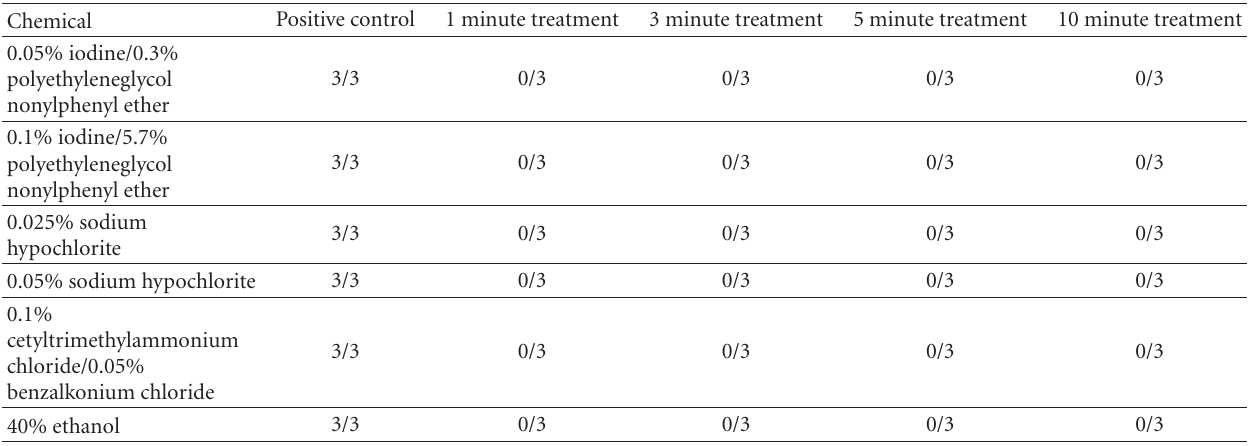
Table 1: The e ff ectiveness of disinfectants on vaccinia virus. Table 1 describes the number of plates (based on triplicate assays) with any wells showing cytopathic e ff ects or plaques.